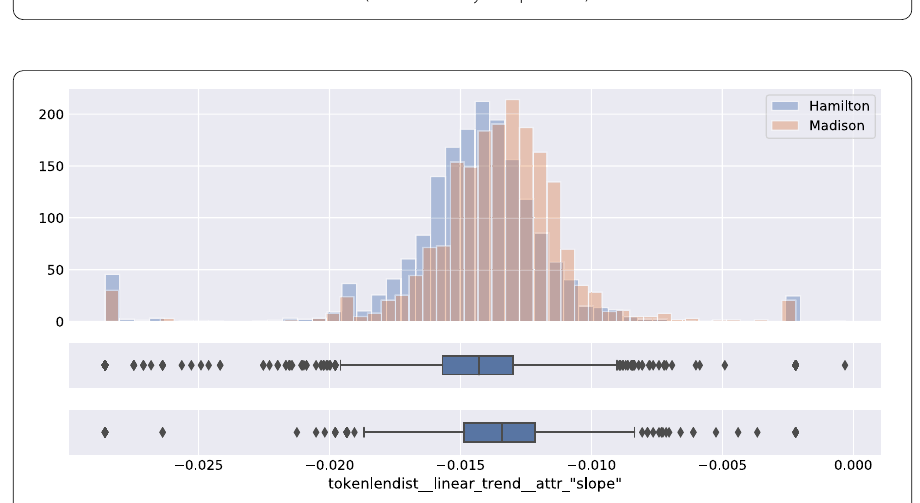
Figure 31 Distribution plot of the feature “linear_trend__attr_‘slope’” of token length sequence time series from classes Hamilton and Madison (normalized by sample